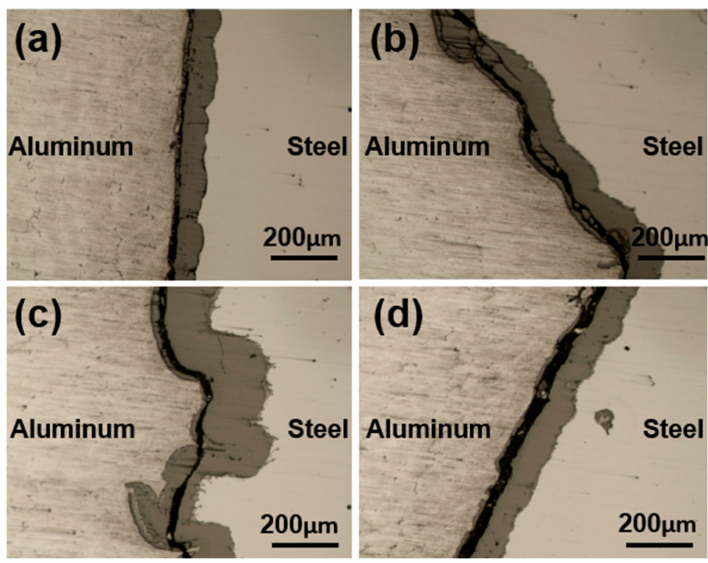
Figure 13. Interface micrographs of the bimetal gear with deformation degree of 70%: ( a ) position 1 (cid:13)